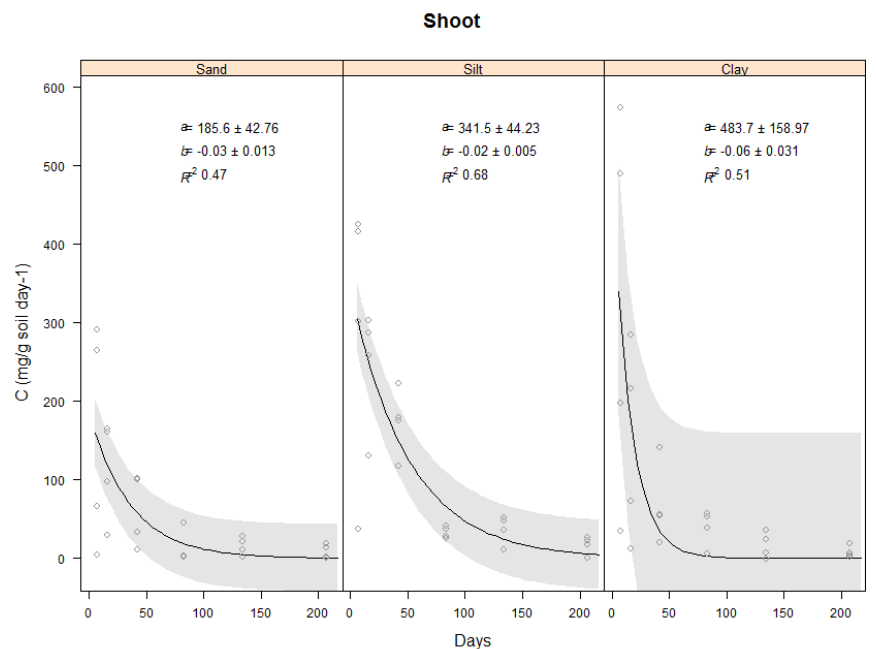
Figure 3. Carbon (mg C g soil − 1 day − 1 ) evolved from the decomposition of vetiver shoot biomass in three soils for 206 days decomposition period. Where vetiver shoot used from the glasshouse experiment and incubated at 25 ◦ C constant temperature. Plots show the raw data (o), a fitted exponential model (–) and 95% confidence bands. Values of the intercept (a), the slope (b) and Coefficient of determination (R 2